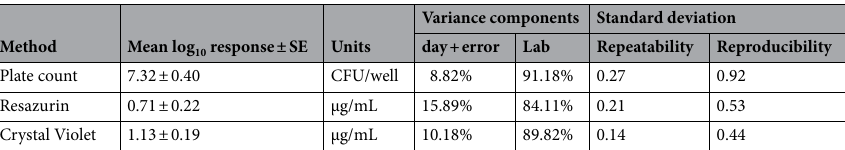
Table 1. Summary of statistical analysis for the ILP control data for each method. The table shows the main conclusions (mean Log values ± Standard Error (SE), variance and standard deviations for repeatability and reproducibility) for the control data using the ILP protocols only for all participating labs, excluding lab 5. Recall from the glossary and methods section that the Repeatability SD is the square root of the “Day + Error” variance, and the Reproducibility SD is the square root of the “total